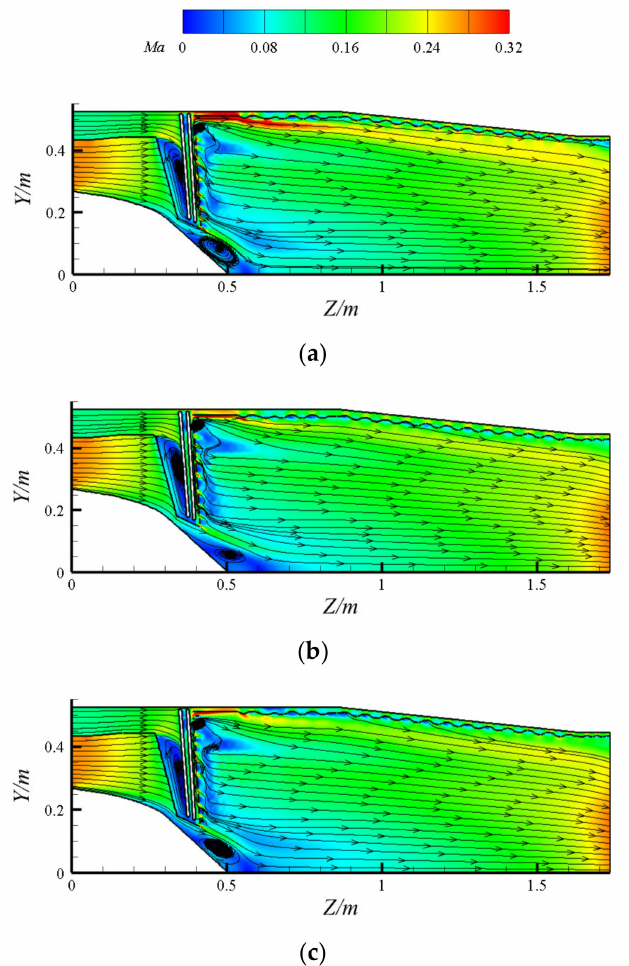
Figure 9. Streamline and velocity distribution on the symmetry plane: ( a ) baseline model; ( b ) r 4 e 1; ( c ) r 1 e 4.